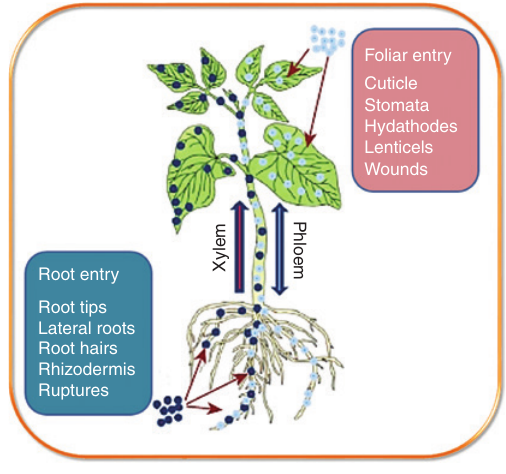
Figure 3: Probable entry points for nanoparticles in plants (Reproduced from Wang et al. [67] with copyright permission from Elsevier).